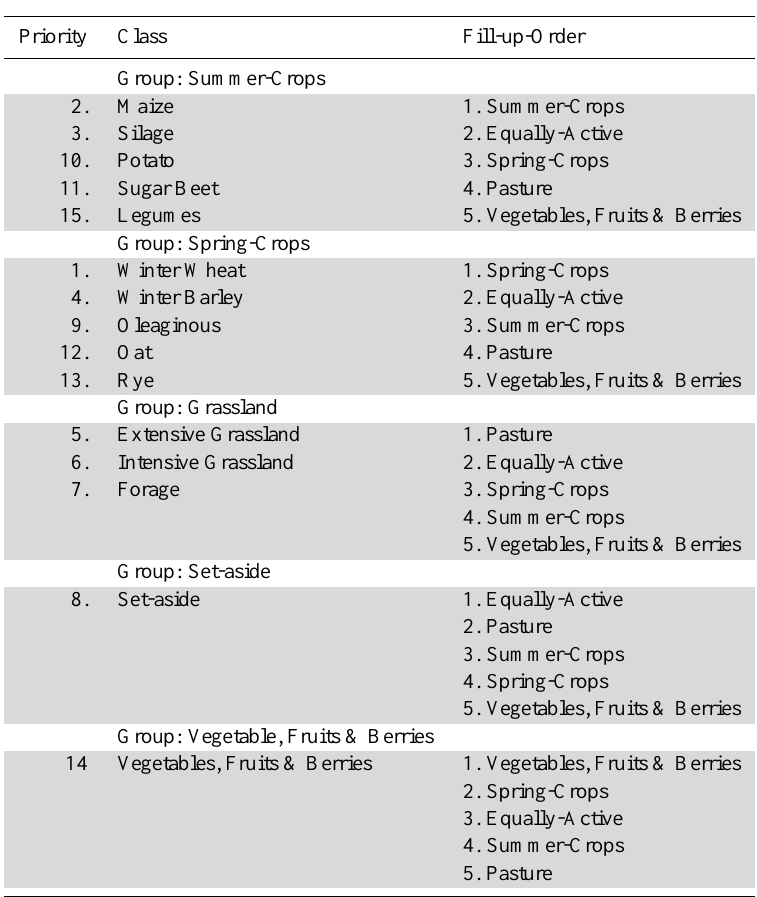
Table 5. Priority list and “Fill-up-Order” for the statistical reclassification of “spring-crops”, “summer-crops” and “equally-active” crops into 15 different types of arable